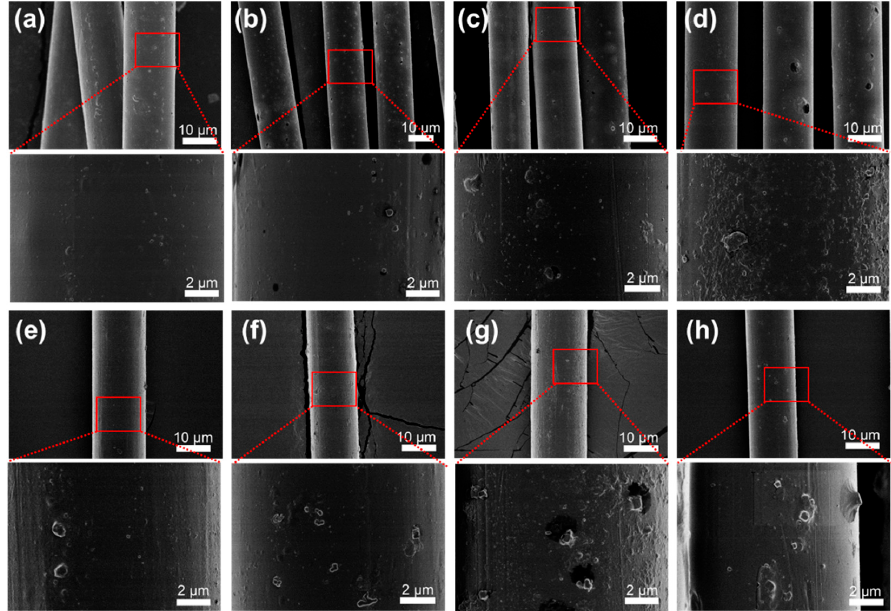
Figure 2. SEM images of ( a ) PET/Cu 2 O@ZrP-I-0.1%, ( b ) PET/Cu 2 O@ZrP-I-0.2%, ( c ) PET/Cu 2 O@ZrP-I-0.4%, ( d ) PET/Cu 2 O@ZrP-I-0.6%; ( e ) PET/Cu 2 O@ZrP-B-0.1%, ( f ) PET/Cu 2 O@ZrP-B-0.2%, ( g ) PET/